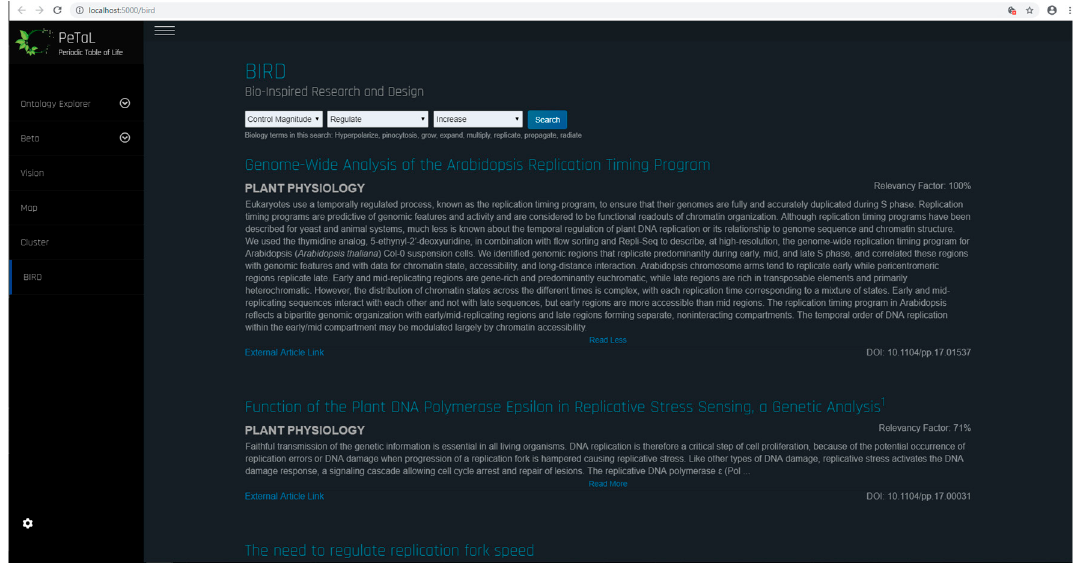
Figure 28. Bio-inspired research and design (BIRD) search interface.